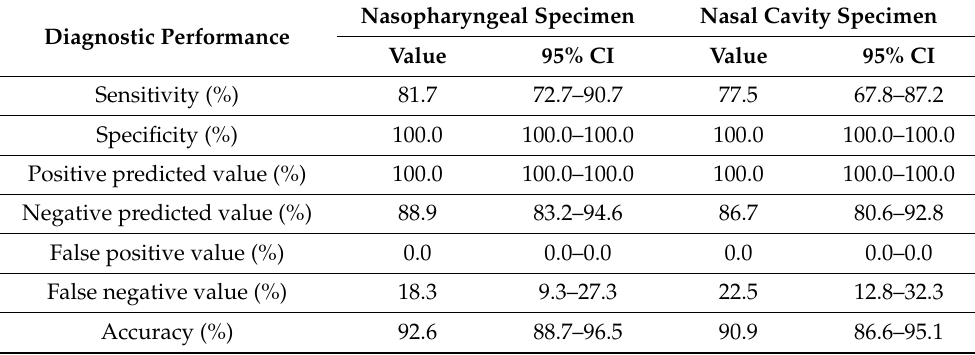
Table 1. Diagnostic performance of the STANDARD Q COVID-19 Ag test compared to real-time